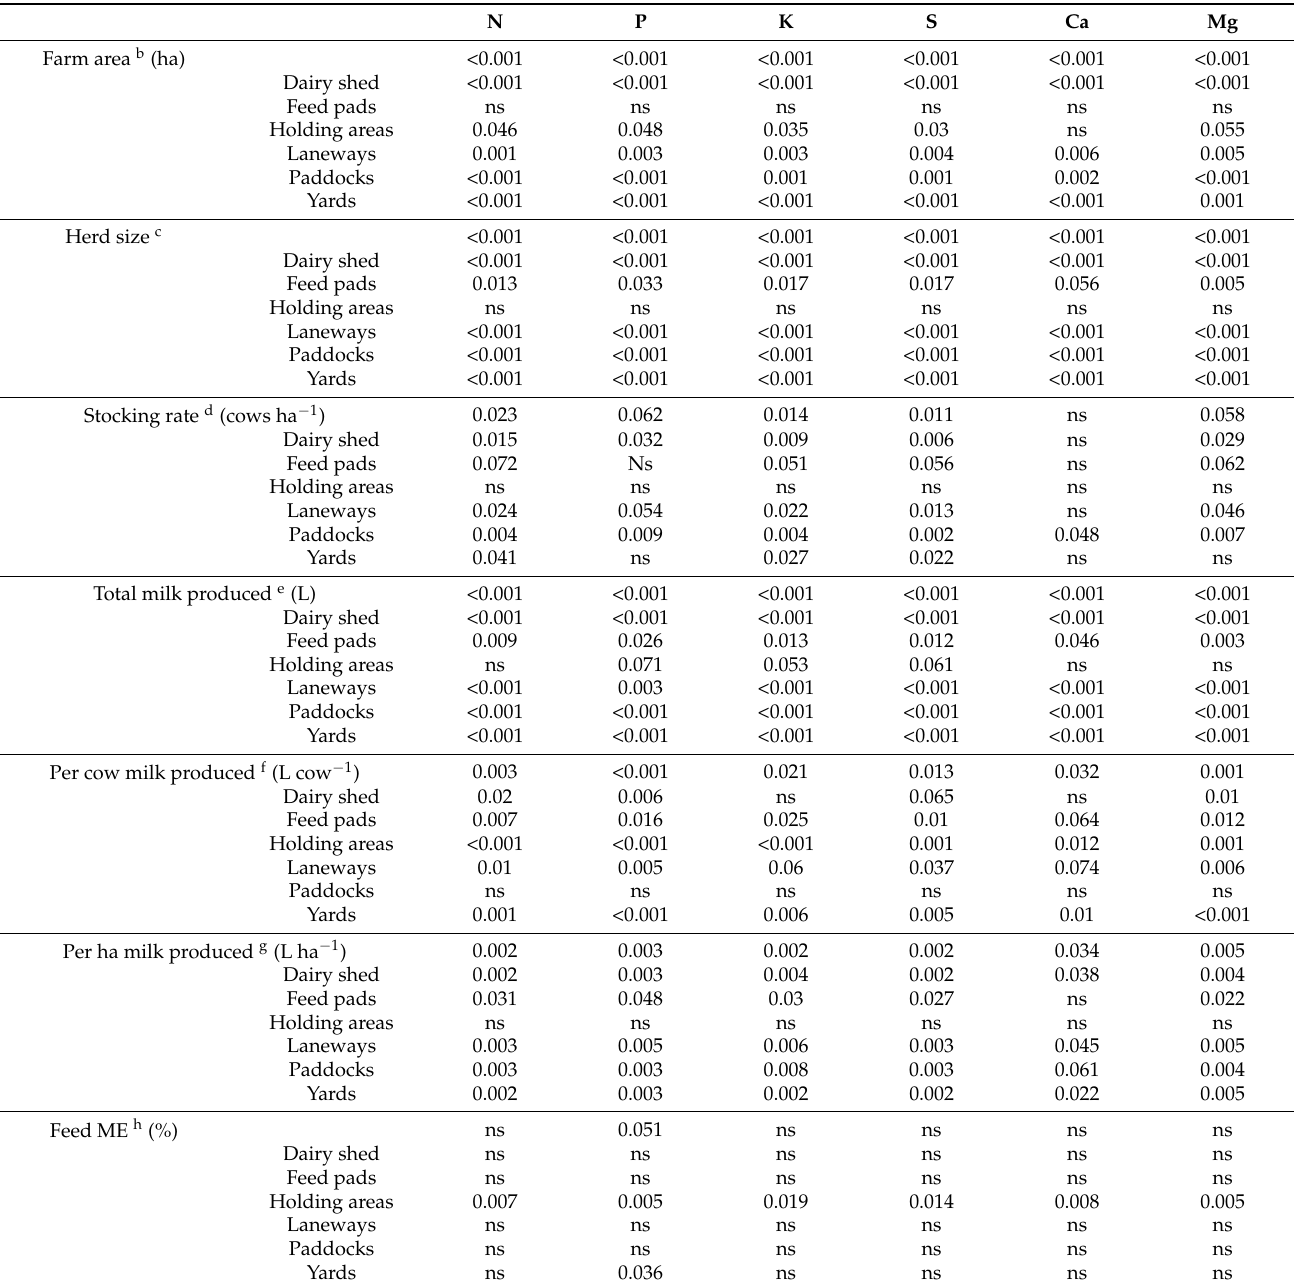
Table 3. F–prob a estimates for positive effects of farm characteristics on nutrient loads excreted on 43 grazing system farms, and for positive effects of farm characteristics on daily nutrient loads excreted in management units (dairy sheds, feed pads, holding areas, laneways, paddocks, yards) on these